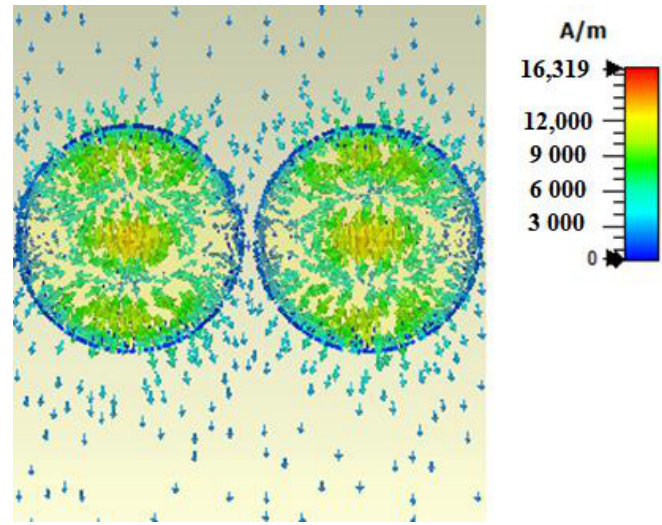
Figure 4. Distribution of surface current at 2.64 THz.